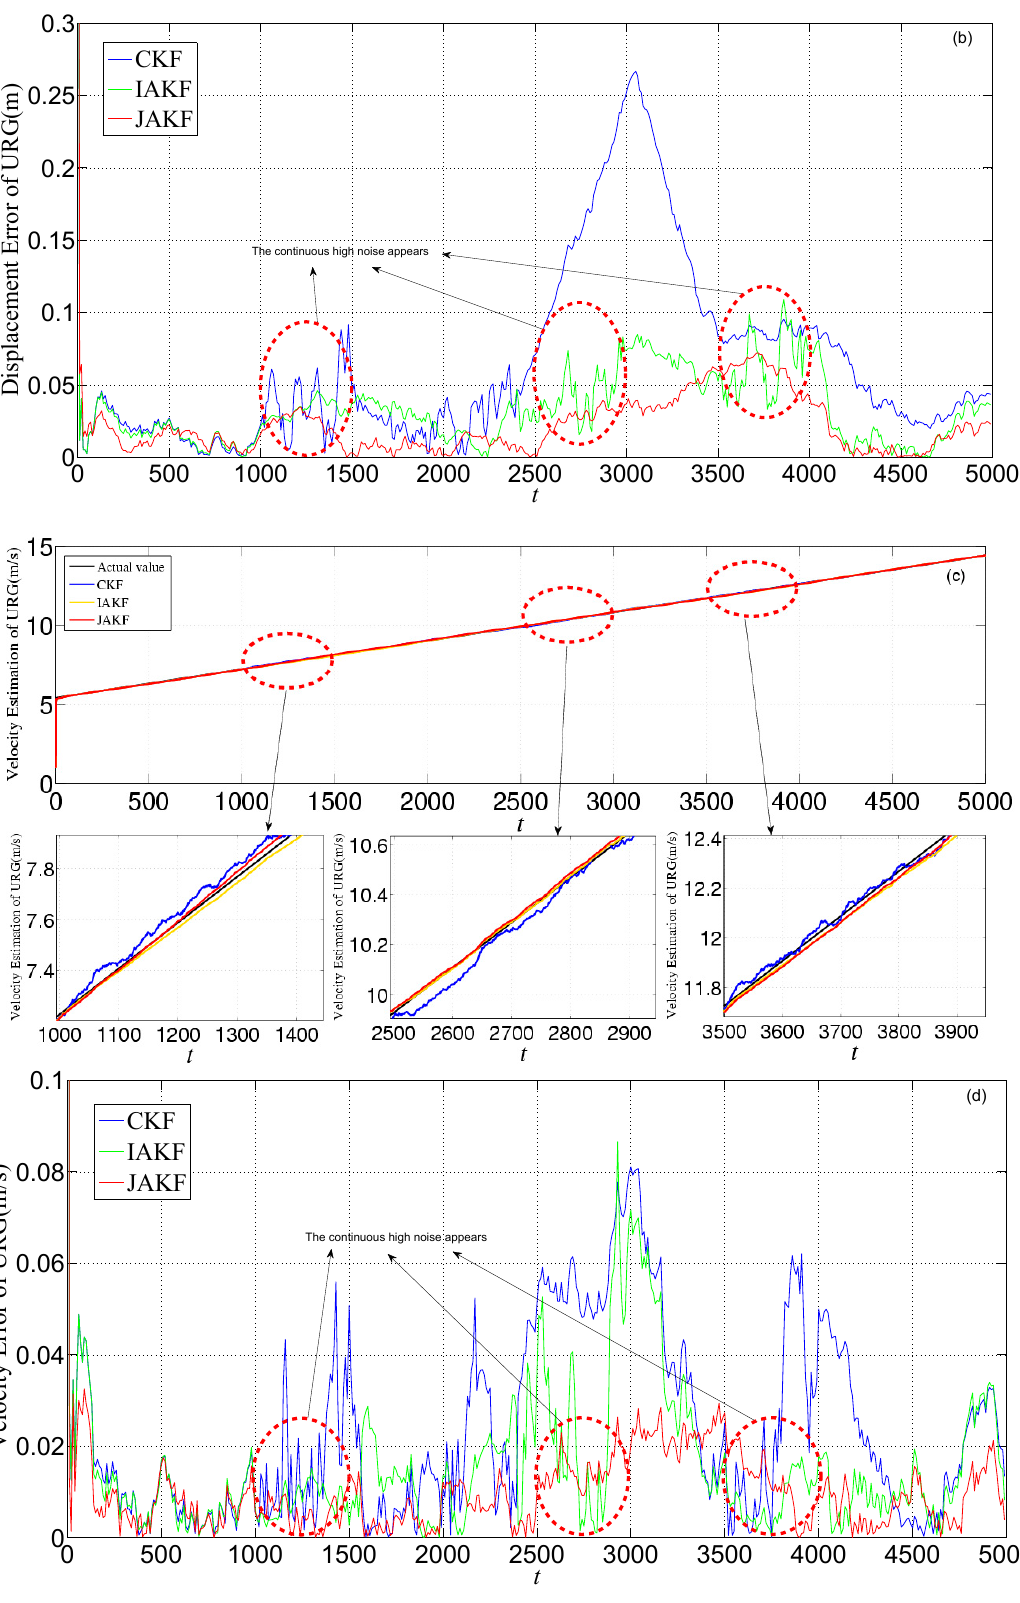
Figure 10 . Cont . Figure 10.